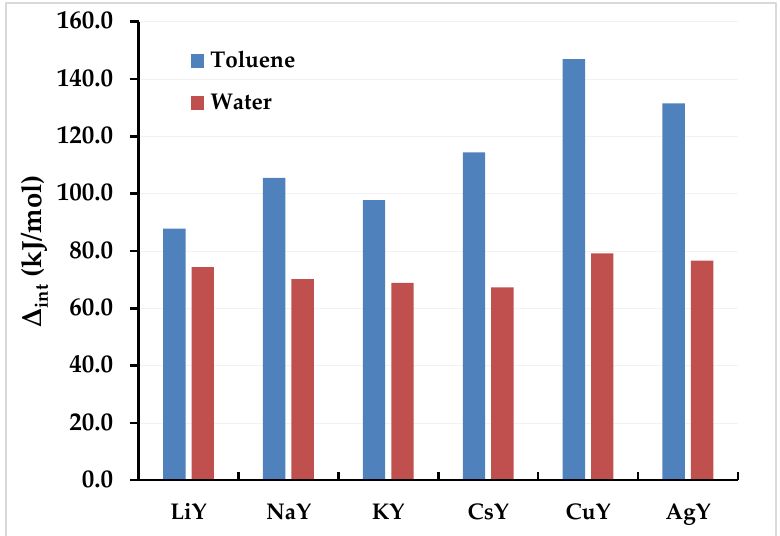
Figure 4. Variation of the interaction energy (kJ/mol) of toluene and water depending on the adsorbent LiY, NaY, KY, CsY, CuY, and AgY.